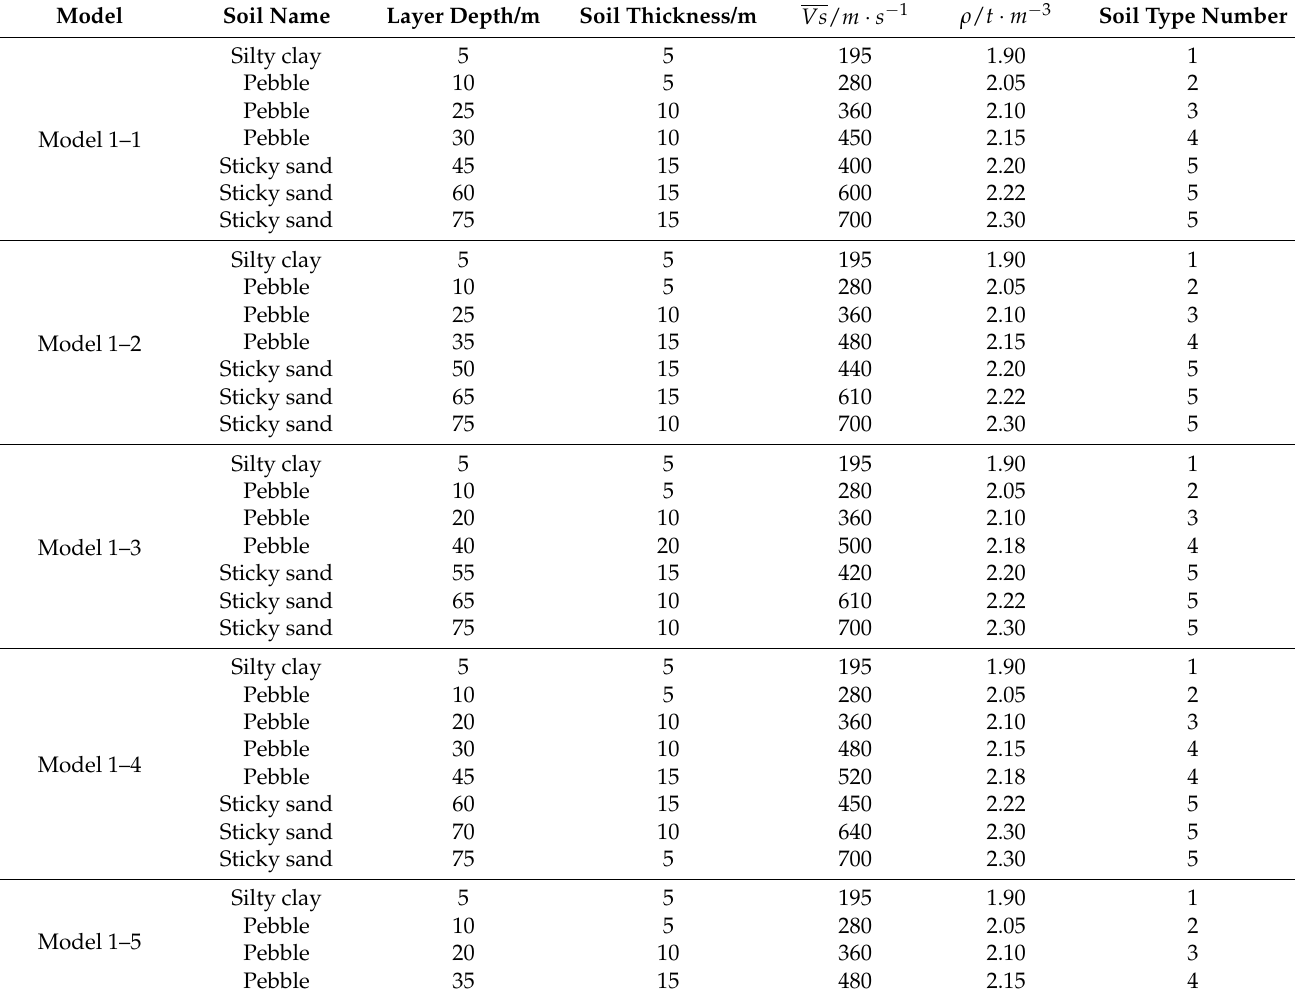
Table 1. Models and soil mechanical